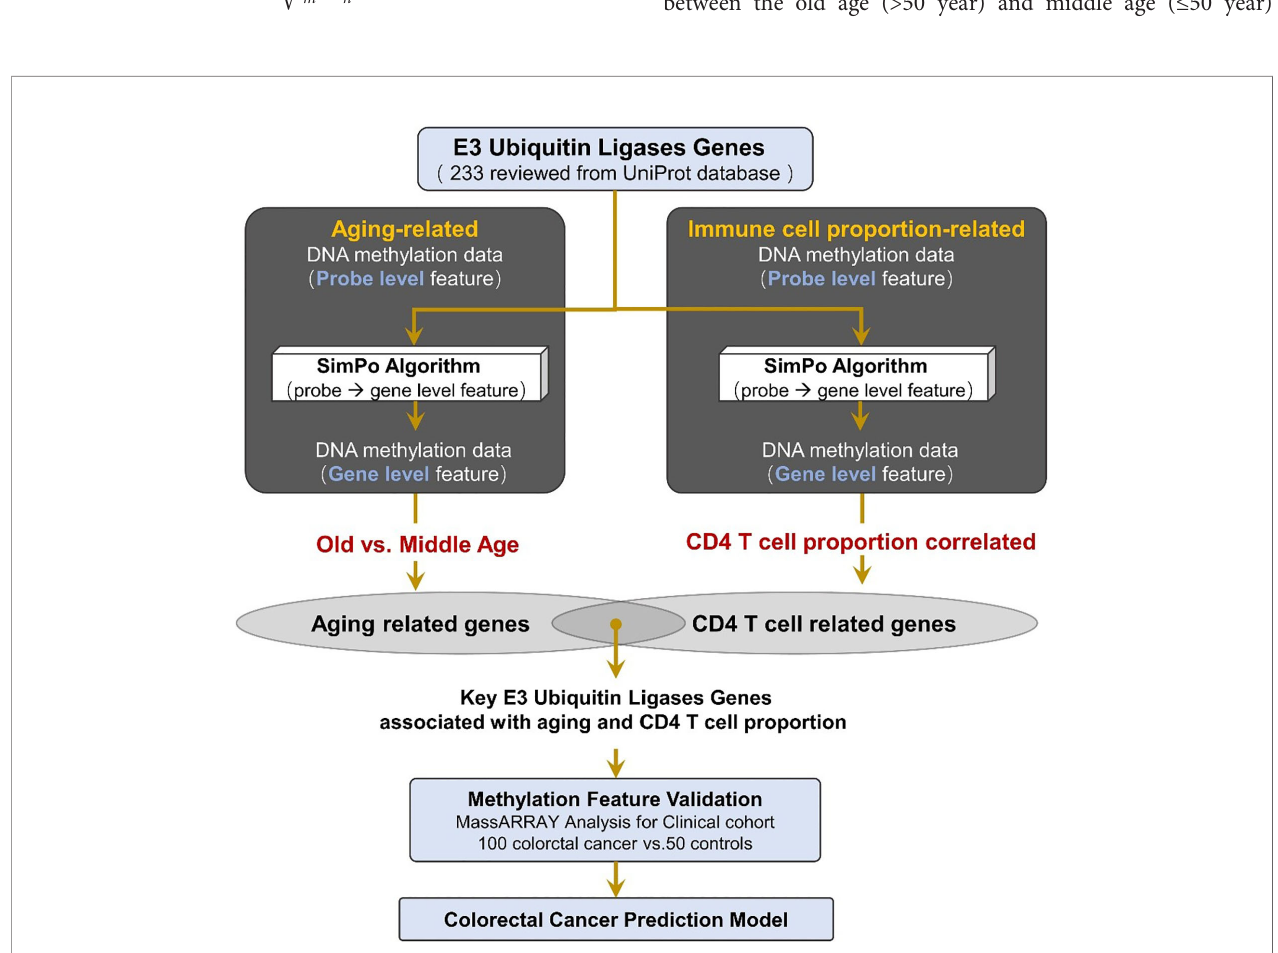
FIGURE 1 | Method pipeline of candidate marker validation and prediction model construction for colorectal